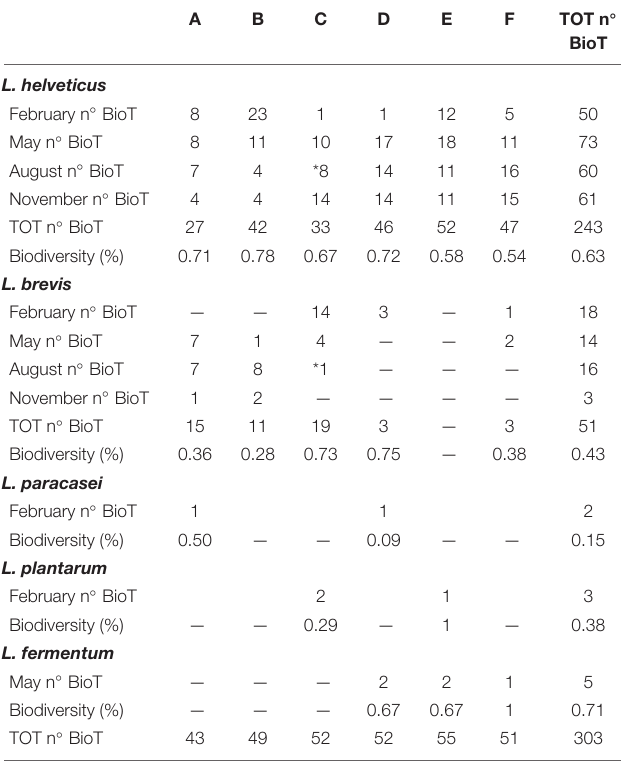
TABLE 3 | Distribution of L. helveticus , L. brevis , L. paracasei , L. plantarum , and L. fermentum biotypes (n ◦ BioT) in NWS samples collected from six dairy factories labeled from A to F four times a year from February to November